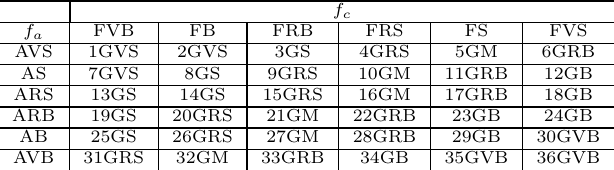
Table 1: fuzzy rules for adjust the crossover proba- bility P c